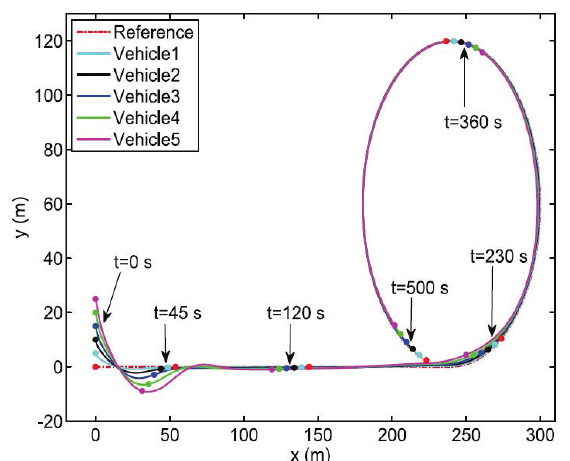
Figure 16. The north-east position of USVs under the method proposed in